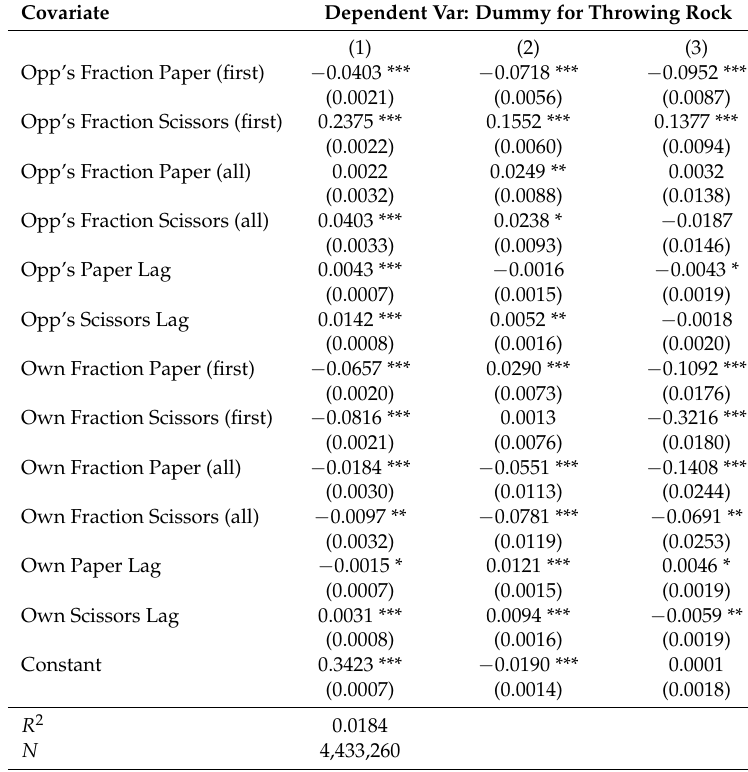
Table A3. Probability of Playing Rock.